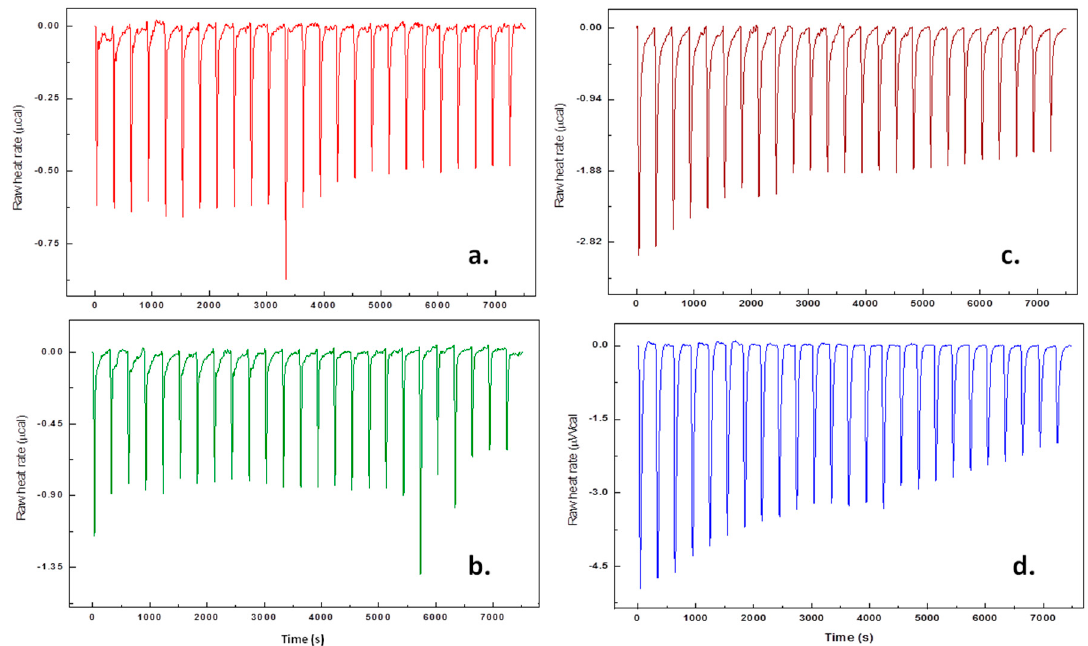
Figure 9. ITC data recorded for the interaction of CA199-His with different materials. ITC response for the blank titration ( a ); the raw data for the titration of 4 mg/mL graphite ( b ); 1 mg/mL GO ( c ); and 4 mg/mL TRGO ( d ) with CA199-His.